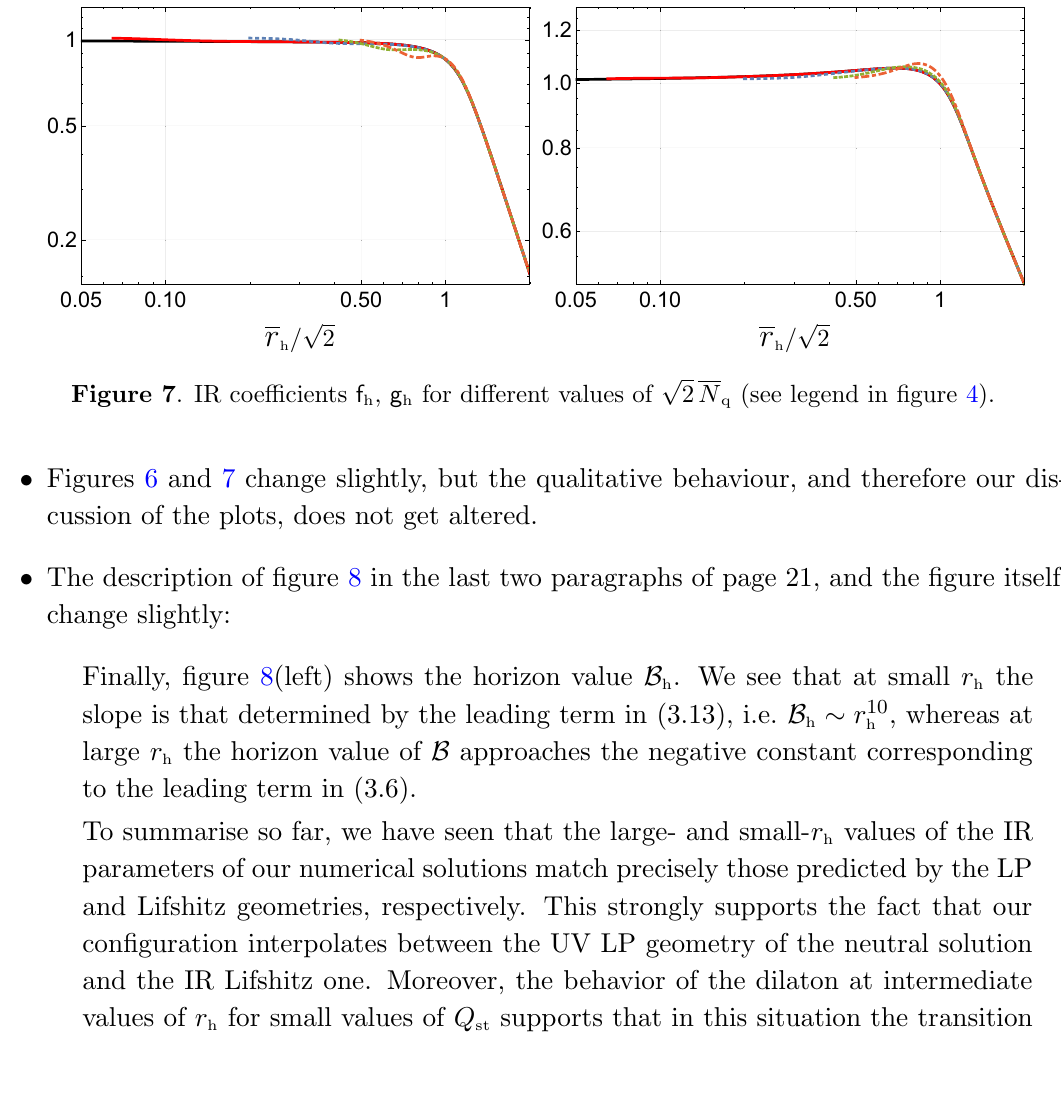
defined in (3.14). h